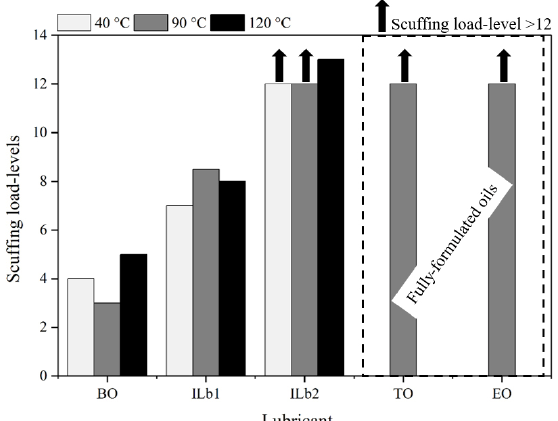
Fig. 6 Average load-carrying capacities of BO, ILb1, and ILb2; also, of the fully-formulated commercial turbine oils used in helicopter applications determined by a standard Brugger tester according to DIN 51347-1.